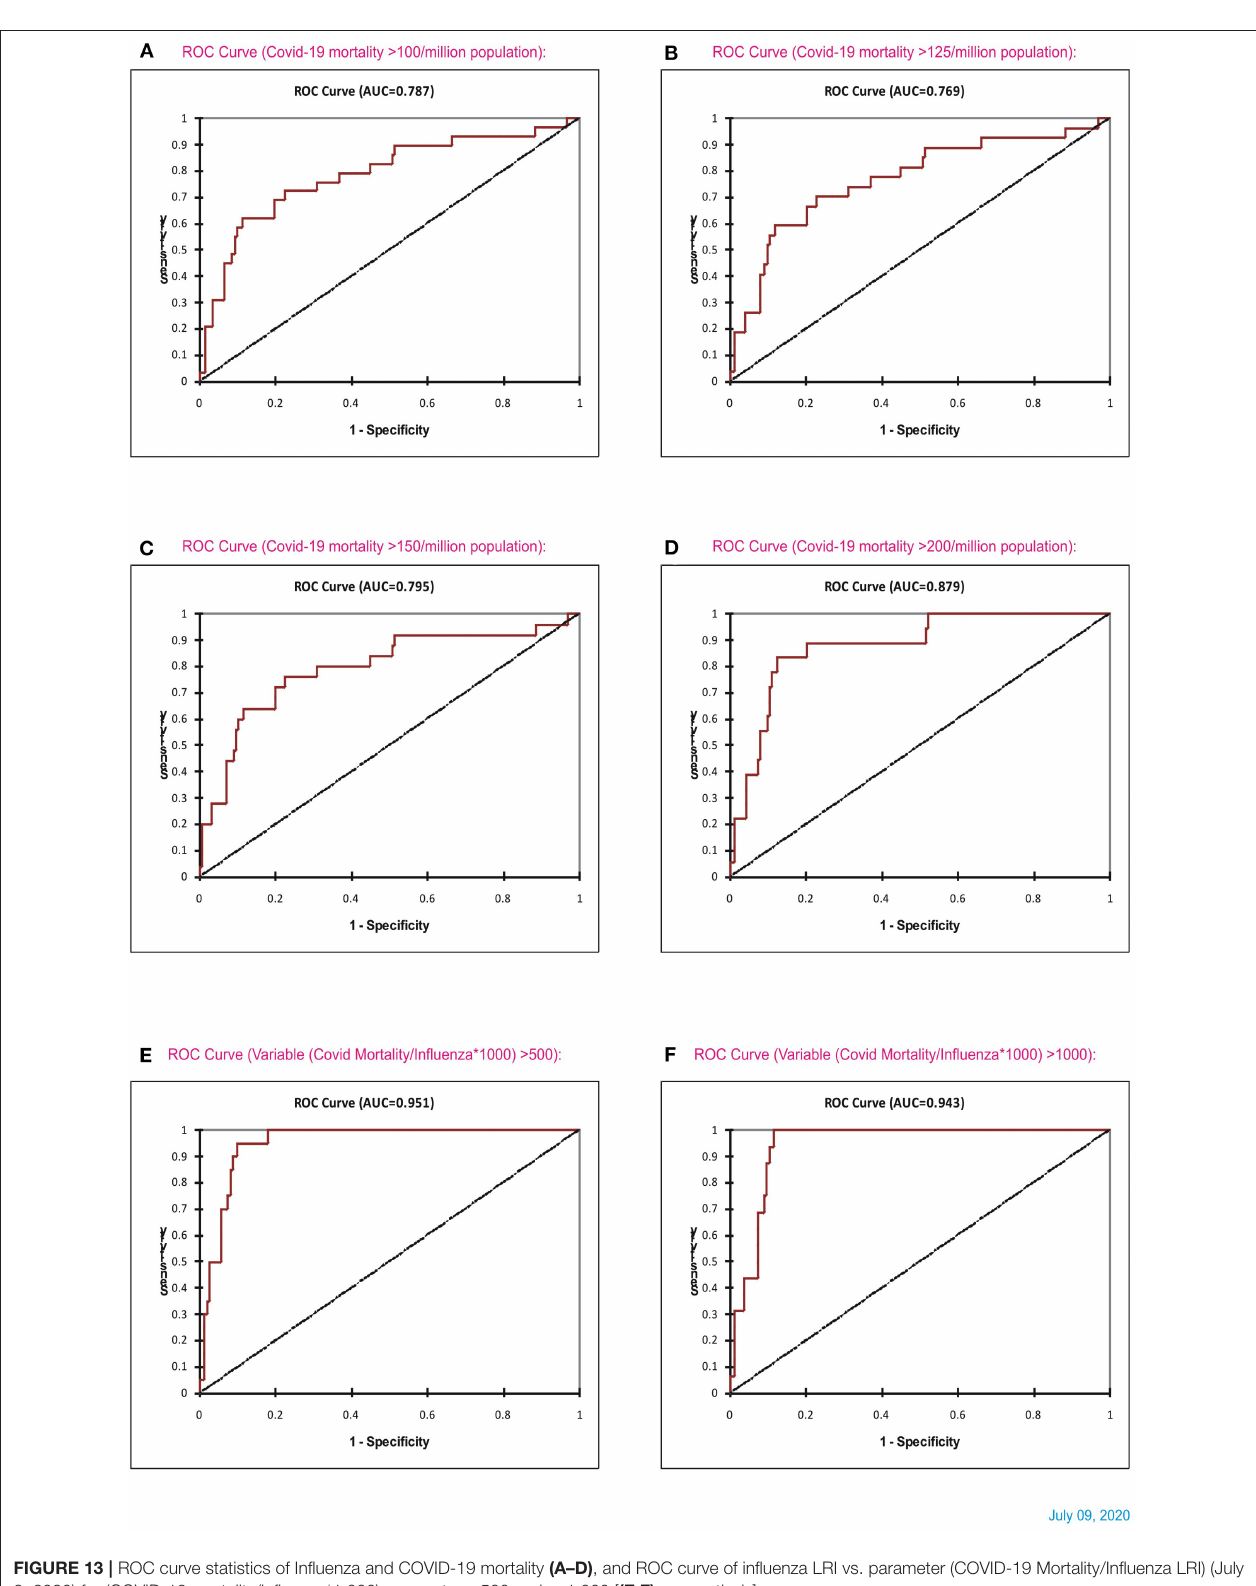
FIGURE 13 | ROC curve statistics of Influenza and COVID-19 mortality (A–D) , and ROC curve of influenza LRI vs. parameter (COVID-19 Mortality/Influenza LRI) (July 8, 2020) for (COVID-19 mortality/influenza*1,000) parameter > 500 and > 1,000 [ (E,F) , respectively].